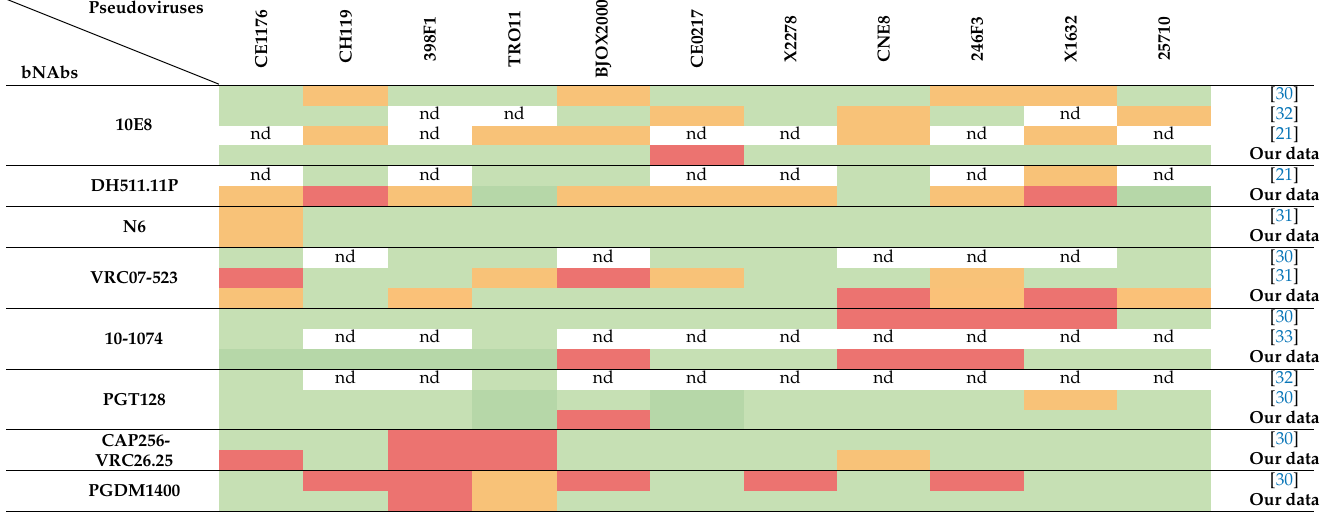
Table 6. Comparison of the IC 50 values for studied bNAbs with literature data [21,30–33].